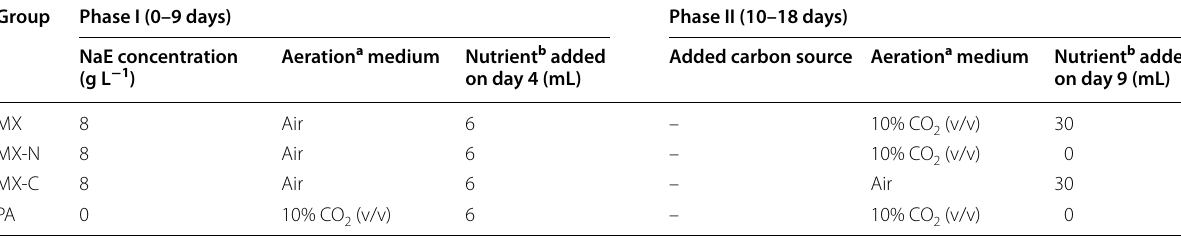
–, no action a Using a flow rate of 60 mL min −